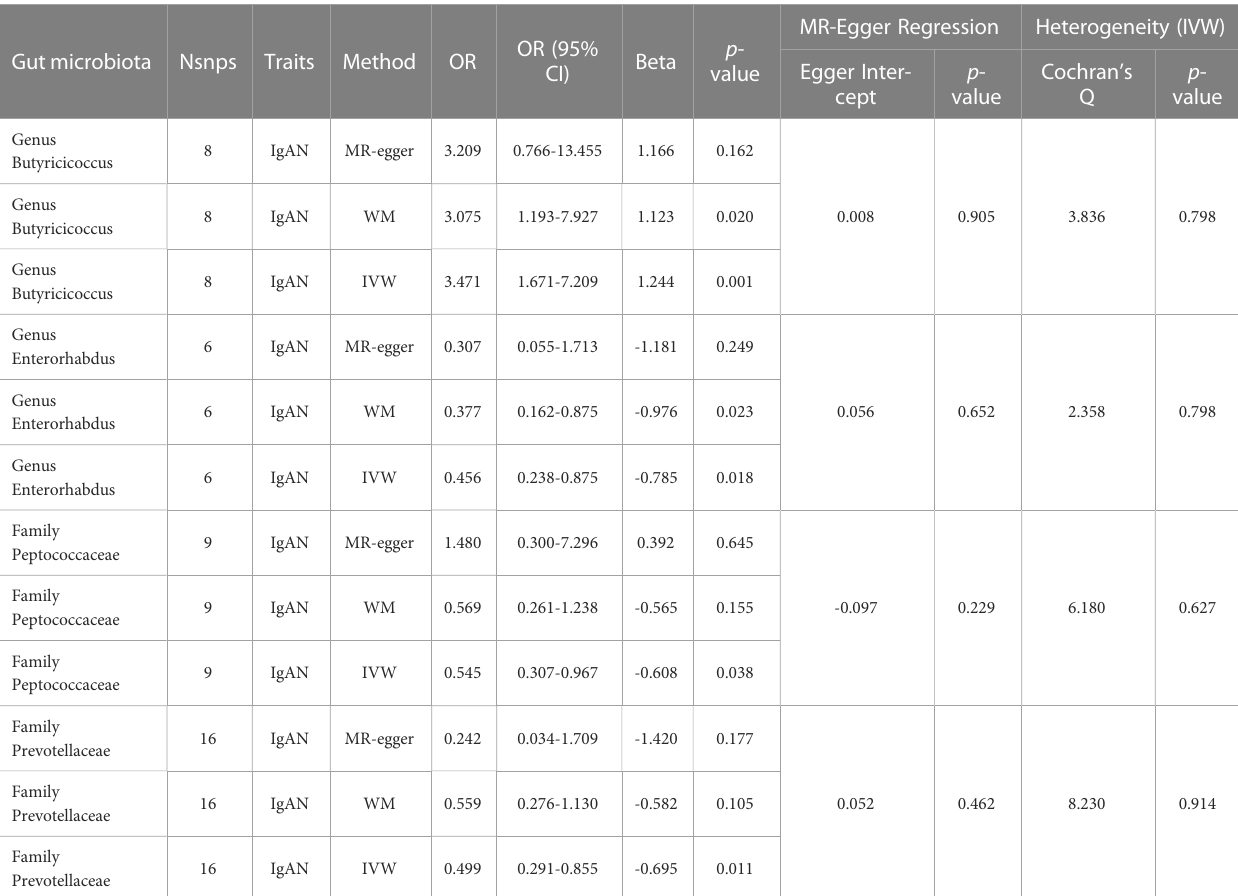
TABLE 1 Signi fi cant MR analysis results of causal links between GM and